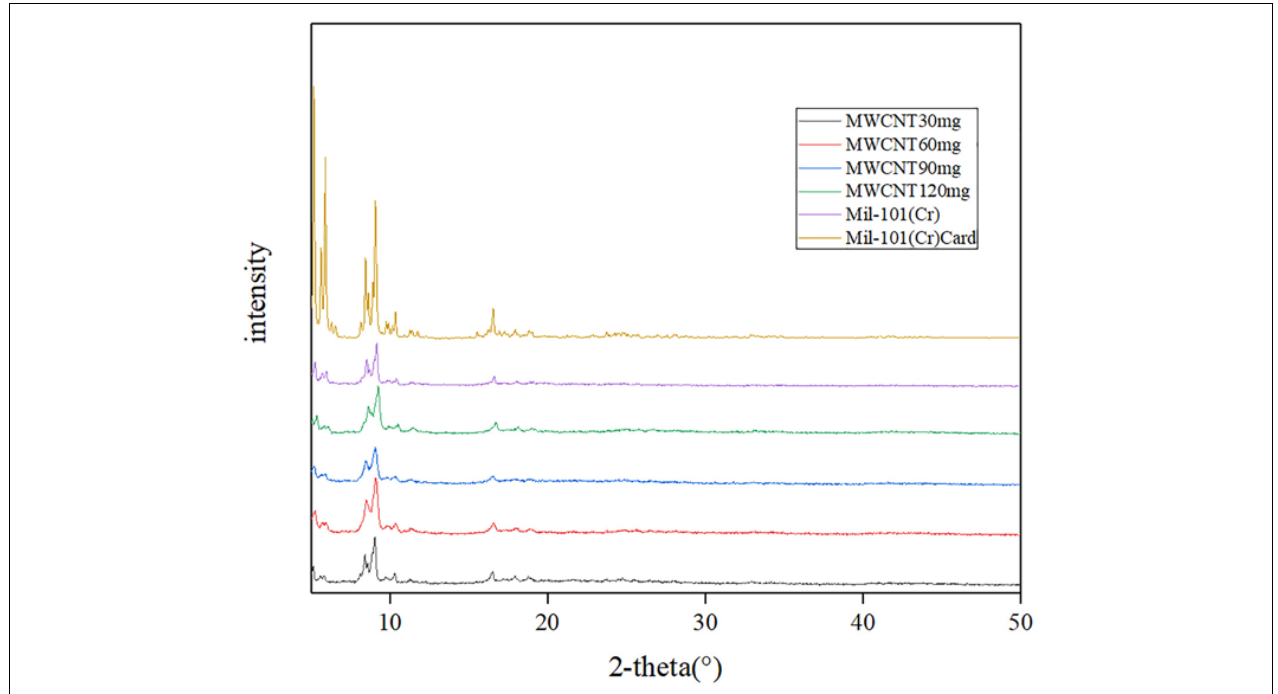
FIGURE 1 | XRD of acidified MWCNTs and mil-101 (Cr) composites with different